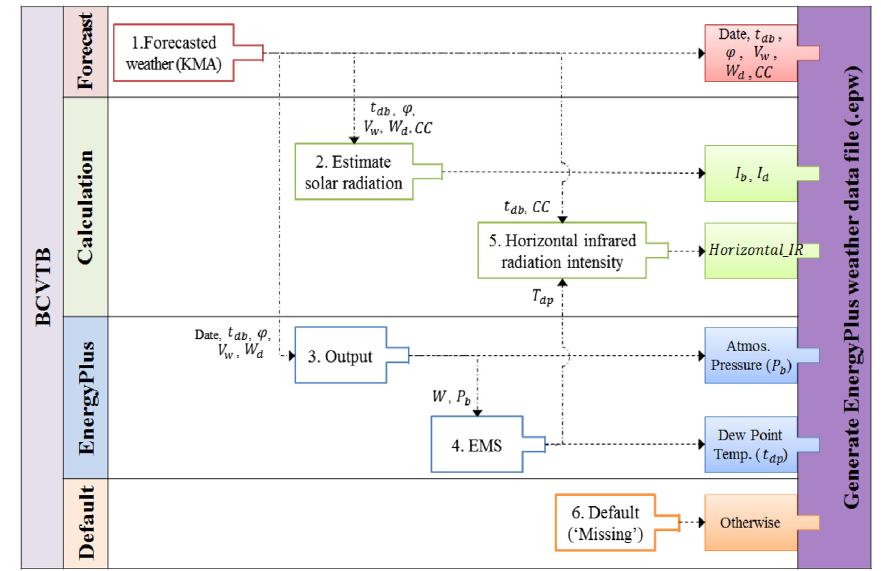
Figure 1. Process of generating a weather data file based on the forecasted weather